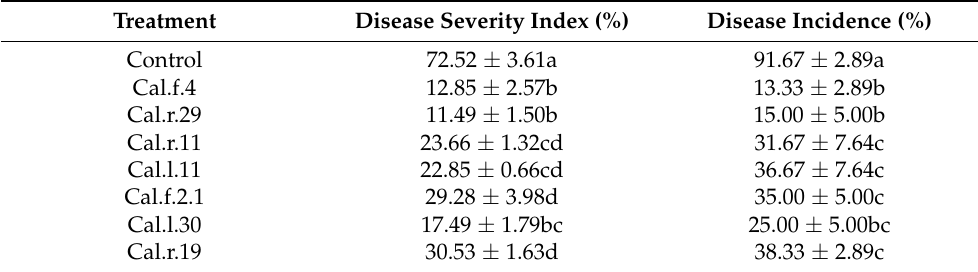
Table 3. Biological control effect of selected bacterial endophytes against Botrytis cinerea on detached tomato fruit. Values represent the mean of three independent replicates and their standard deviations. Different letters indicate statistically significant differences among treatments, based on Tukey’s test at p =